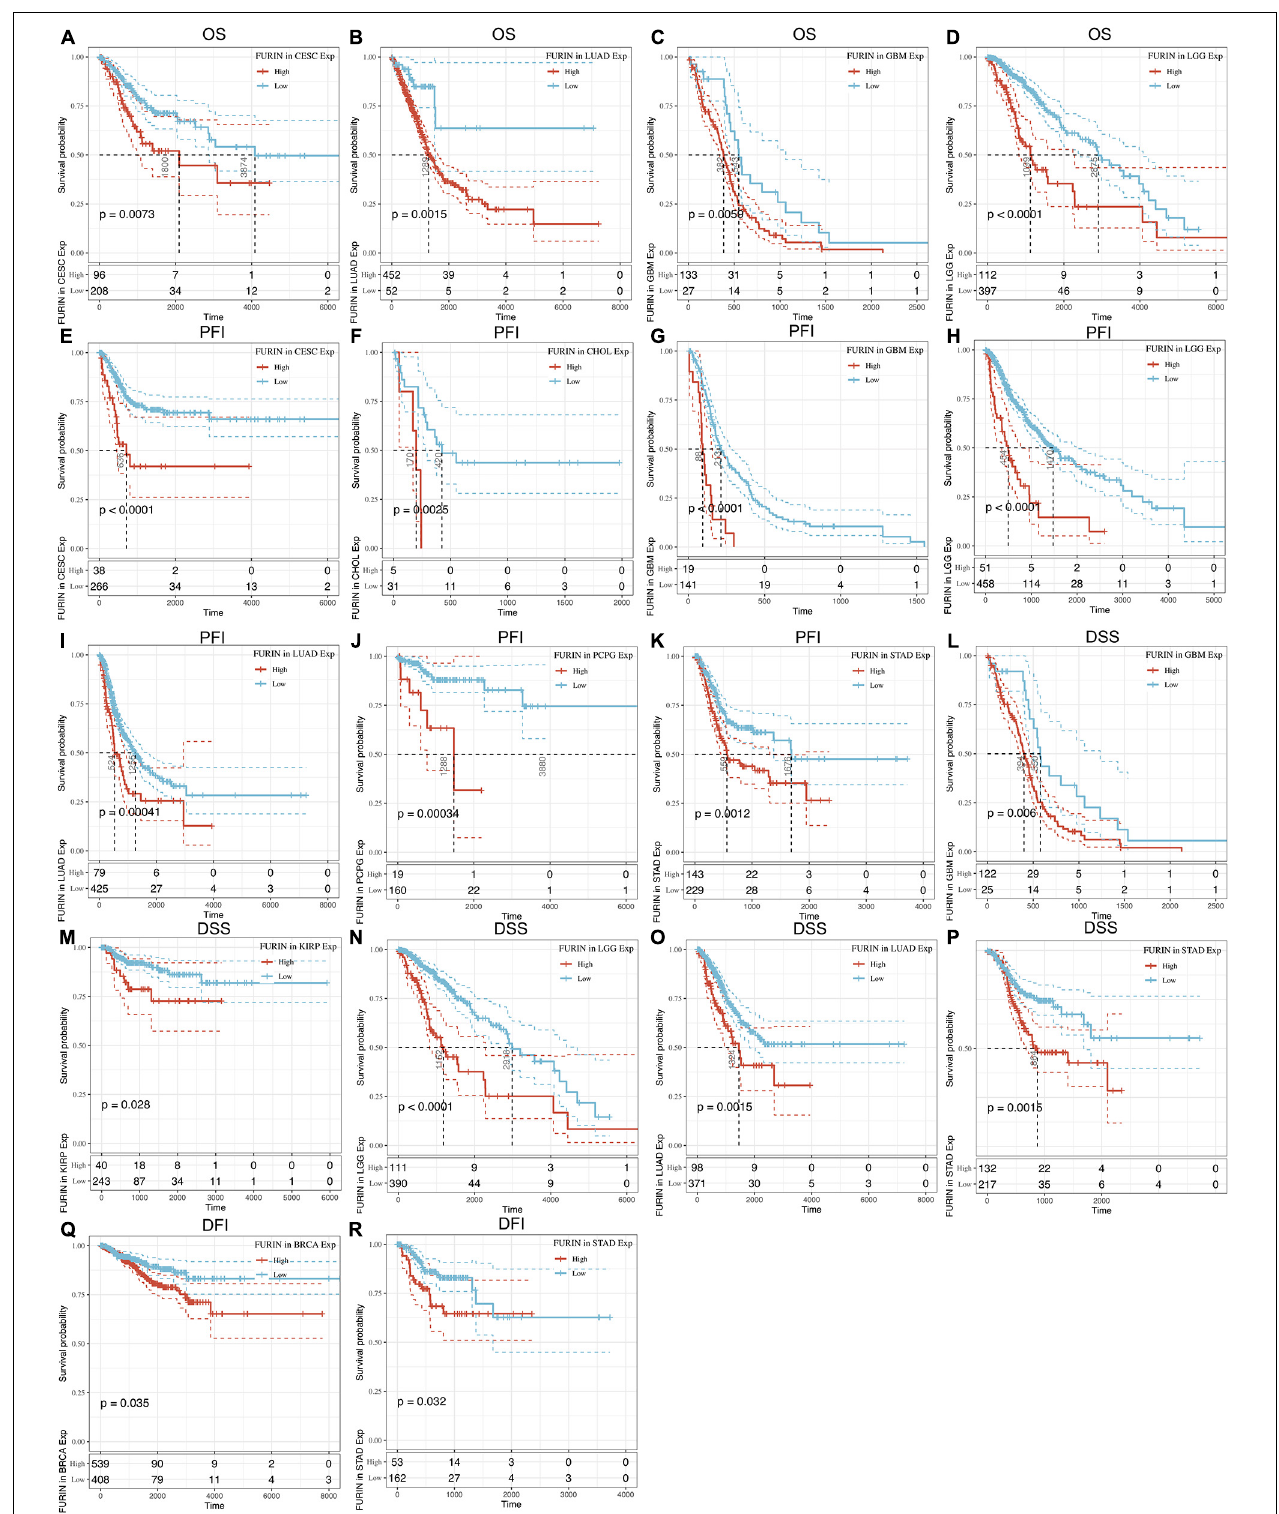
FIGURE 3 | Correlation between FURIN expression in patients with OS, PFI, DSS, and DFI. (A–D) Survival analyses of FURIN expression using the Kaplan–Meier OS curves in CESC, LUAD, GBM, and LGG. (E–K) Survival analyses of FURIN expression using the Kaplan–Meier PFI curves in CESC, CHOL, GBM, LGG, LUAD, and PCPG. (L–P) Survival analyses of FURIN expression using the Kaplan–Meier DSS curves in GBM, KIRP, LGG, LUAD, and STAD. (Q,R) Survival analyses of FURIN expression using the Kaplan–Meier DFI curves in BRCA and STAD.